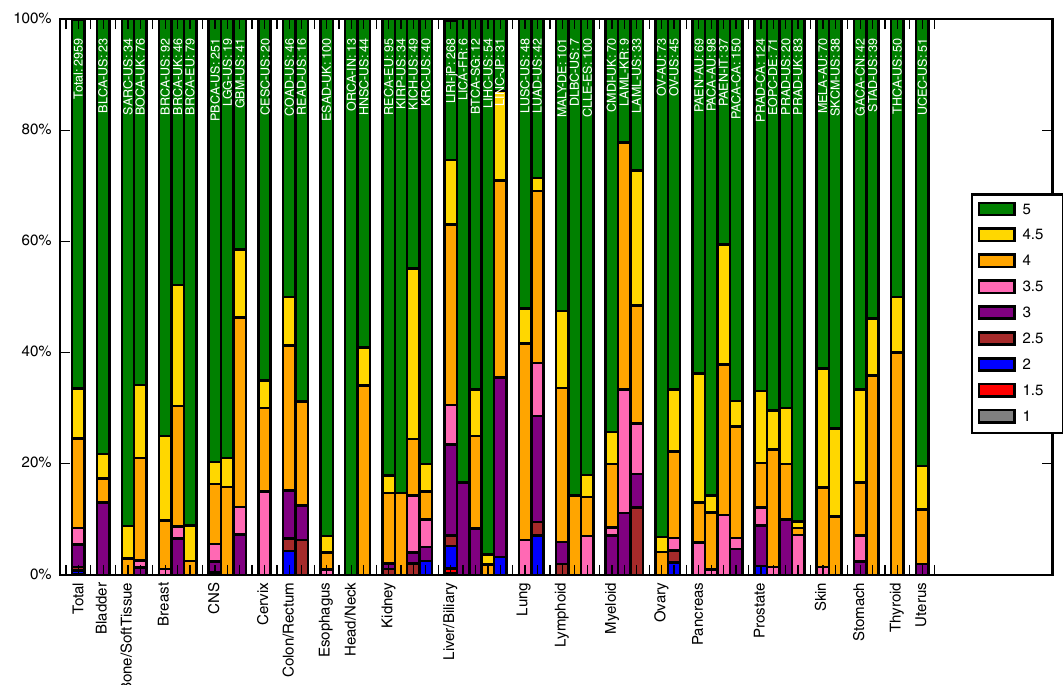
Fig. 3 Distribution of the star ratings for the PCAWG genomes. The samples are grouped by tissue type (as labelled along the x -axis), and then project. The project name and number of samples in the project are labelled at the top of the bar. The colour of the bar re fl ects what percentage of samples in the project have that star rating (corresponding to the legend). The bar on the far left shows the results for all samples. The plot demonstrates the varying quality of different projects — differences we believe come from when the genome was sequenced and the sequencing protocol subset of 348 samples sequenced at the Broad Institute (Supplementary Fig. 9), which had metadata recorded in CGHub 27 about the time and instruments used to sequence.